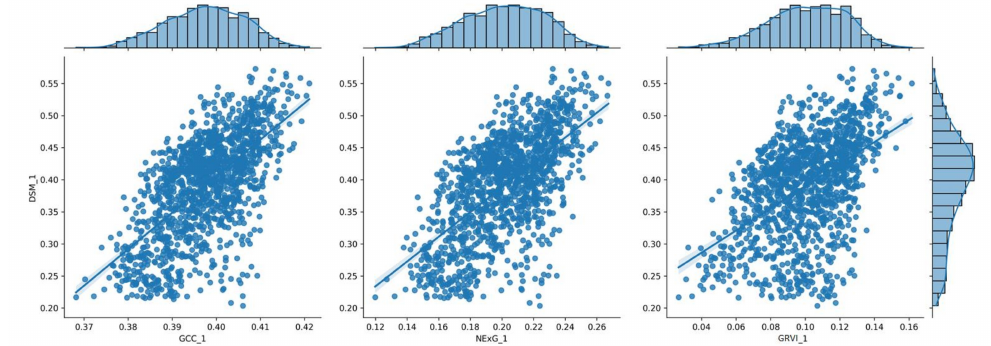
Figure 7. The distribution of the three (3) vegetation index values for the 1st measurement (20 DAS), shown in a histogram in relation to the corresponding DSM values.